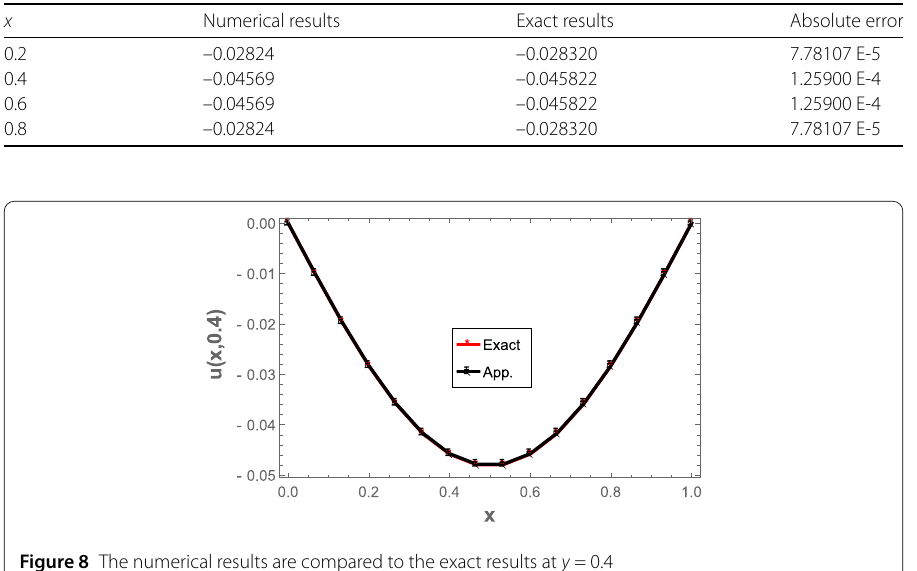
Figure 8 The numerical results are compared to the exact results at y = 0.4